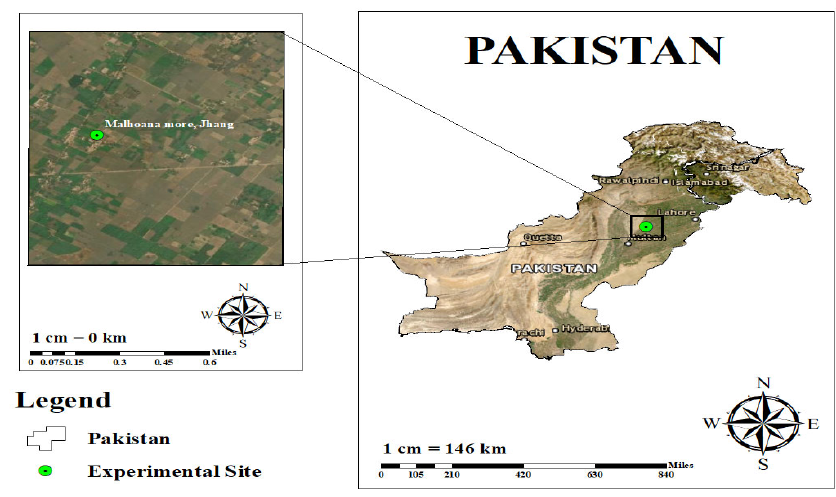
Figure 1. Study area.